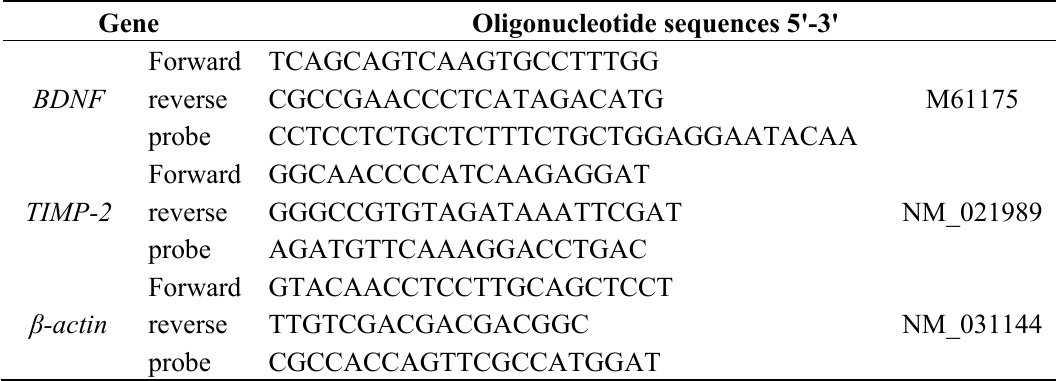
Table 1. Sequences of oligonucleotides and gene